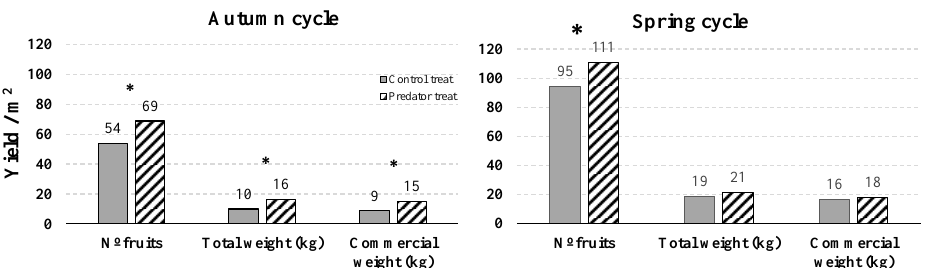
Figure 7. Number of fruits, total fruit weight, and weight of commercial fruits in the two treatment plots for the two crop cycles performed. Black asterisks indicate significant differences.